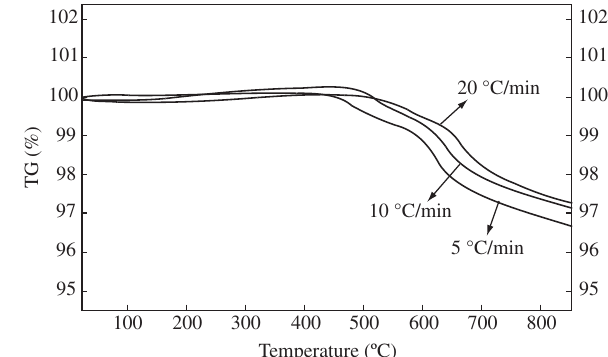
Figure 3. TGA curves for δ -TiH 20 °C.min -1 .